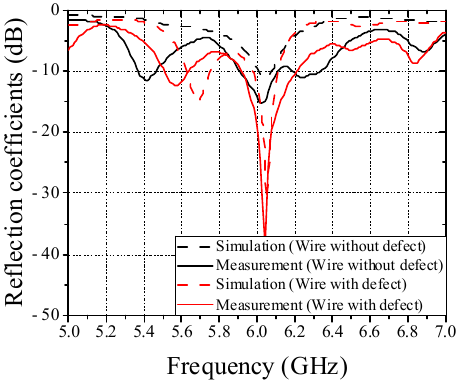
Simulation (Wire without defect) Measurement (Wire without defect) Simulation (Wire with defect) Measurement (Wire with defect)